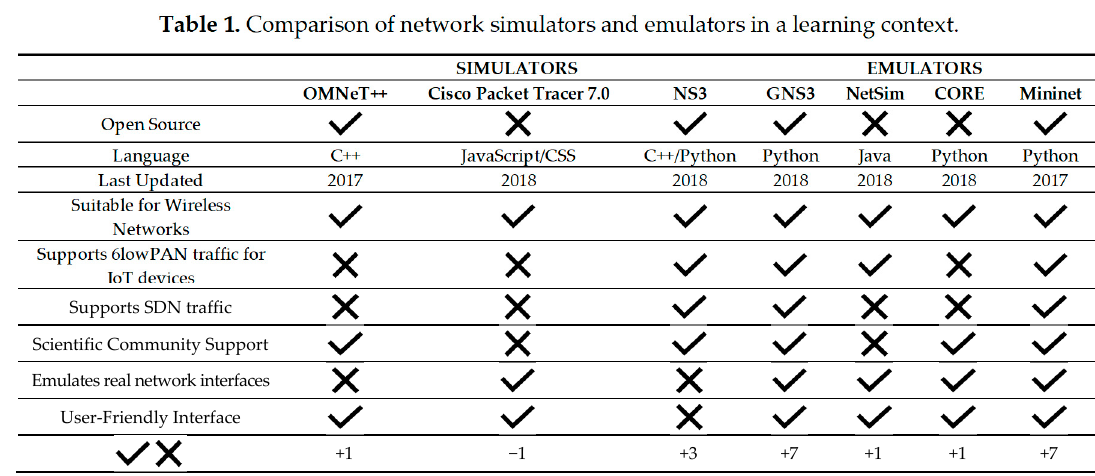
Table 1. Comparison of network simulators and emulators in a learning